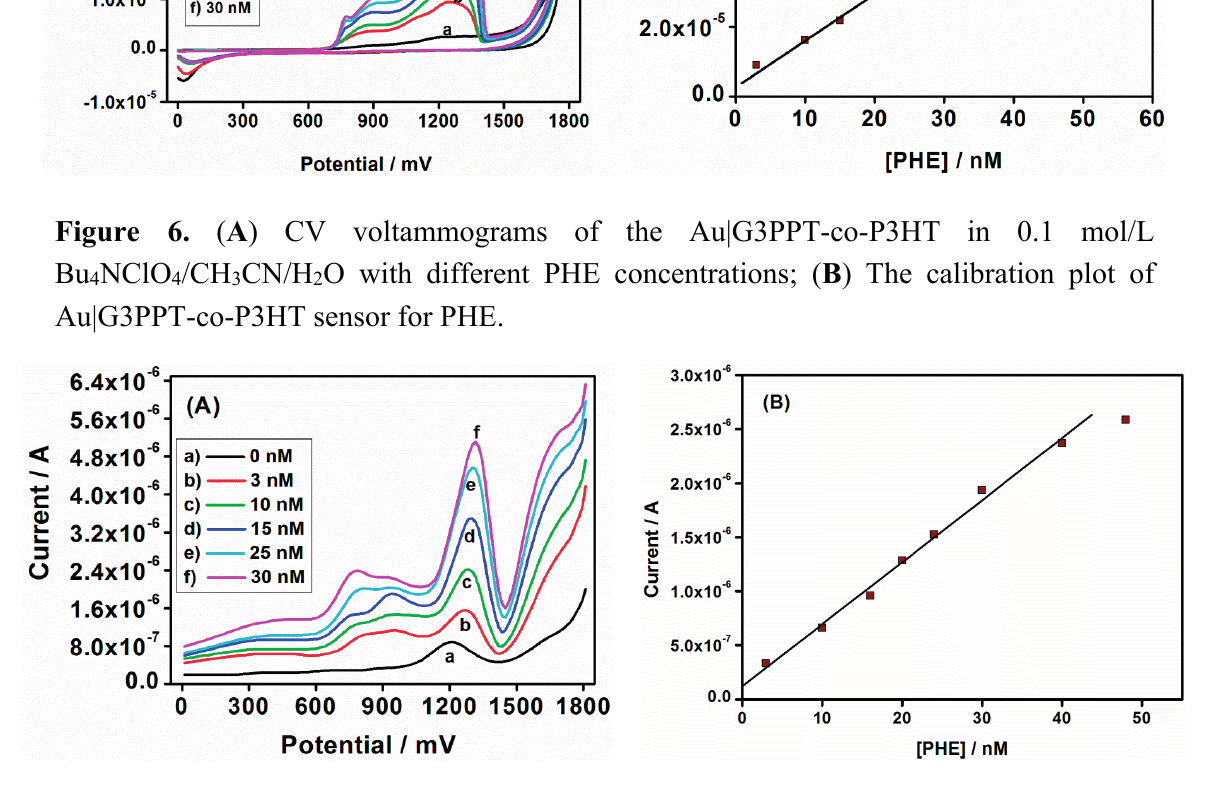
Figure 7. ( A ) AC voltammograms of Au|G3PPT-co-P3HT in 0.1 mol/L Bu 4 NClO 4 /CH 3 CN/H 2 O with different PHE concentrations; ( B ) The calibration plot of Au|G3PPT-co-P3HT sensor for